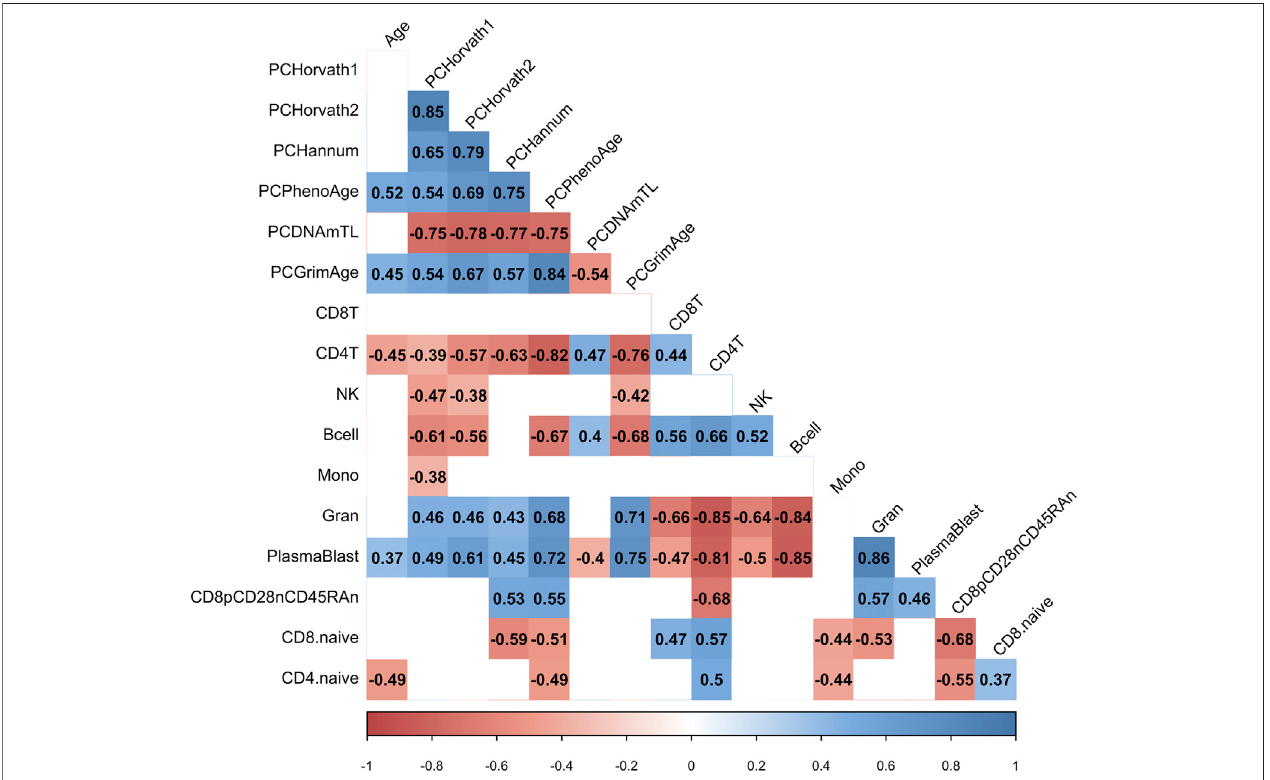
FIGURE 5 | COVID-19-related epigenetic clock changes associate with immune cell type changes. Correlogram plot of biological age, the change in PC-based epigenetic clocks pre- vs. post-COVID-19, and the change in inferred immune cell type following COVID-19. Signi fi cant correlations displayed as solid box and Spearman ’ s rank correlation coef fi cient